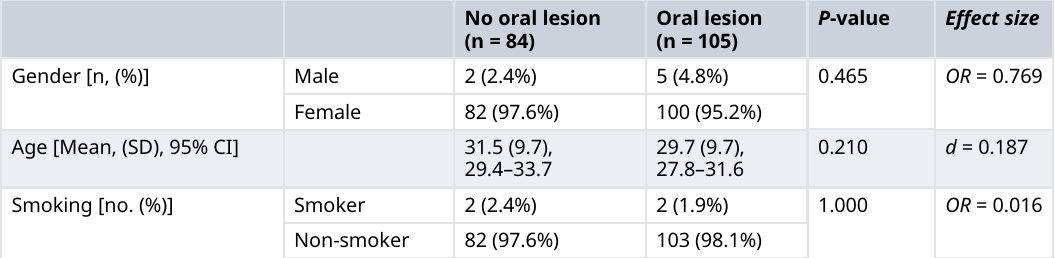
Table 1. Descriptive statistics, results of Fisher ’ s Exact test, and Student ’ s t-test for comparison between patients with and without oral